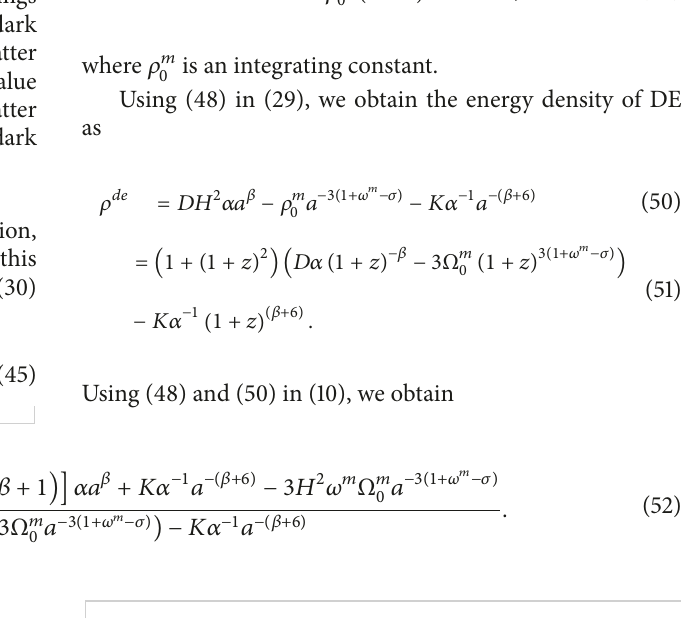
these parameters. It is observed that, for sufficiently large time, the overall density parameter ( Ω ) approaches to